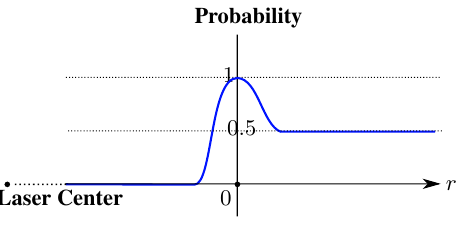
Figure 4. Probabilistic occupancy in ray direction From the laser scanner center to the point, the laser beam has travelled through the space that is free, hence the probability is 0. At the location of the point, the space is occupied. Due to laser range measurement errors and positioning errors from the map- ping system, the point position has certain degree of uncertainty, which can be accounted for by coupling a random error distribu- tion to the probability both behind and ahead of the point along the ray direction. Further ahead of the point along the ray, the space is not scanned hence can be either free or occupied. Then the probability of occupancy is defined as 0.5. Different from DST, the probabilistic occupancy only has one value to represent the space’s occupancy